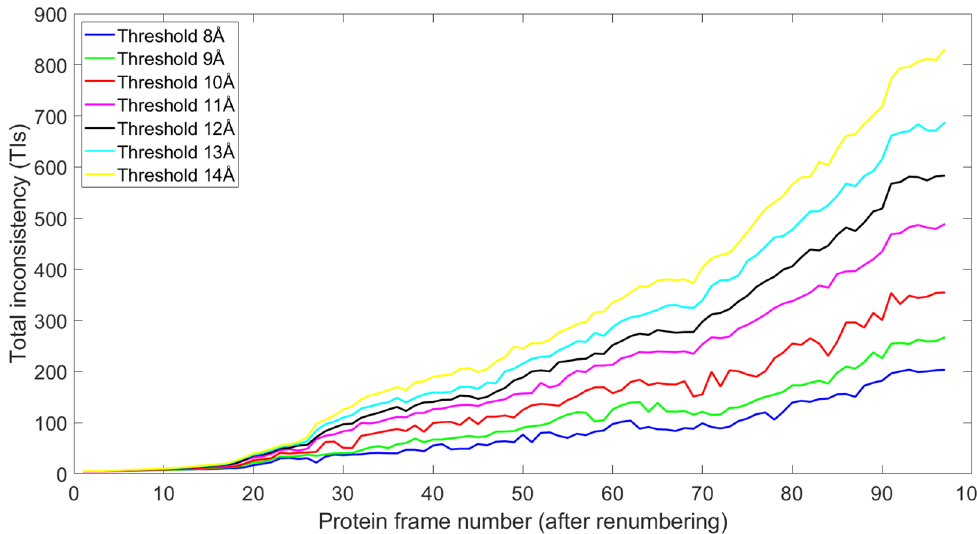
Figure 6. The illustration of total inconsistency (TI) for Titin configurations during the SMD simulations. A renumbering is considered so the first configuration is the last one in the SMD simulation. It can be seen that TIs are monotonically increasing when protein folds from a straight line to its 3D